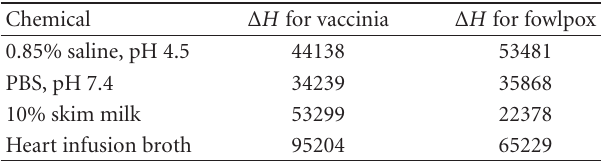
Table 4: Δ H (heat of activation) of vaccinia and fowlpox viruses in various solutions. Values are reported in calories per mole.